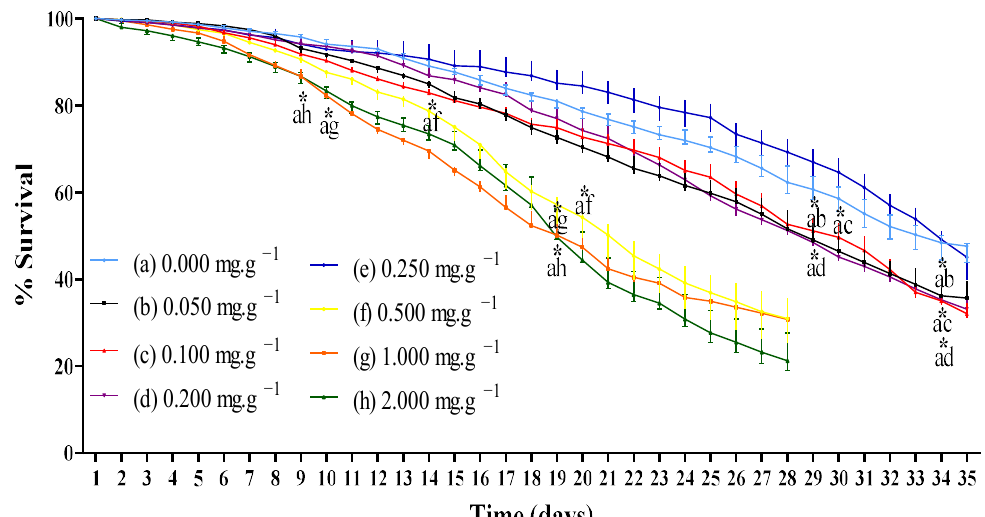
Figure 2. Survival curve of Drosophila melanogaster flies exposed to TFSR in different concentrations. The values are expressed as means ± S.E.M ( n = 3) as calculated by one-way ANOVA followed by Tukey’s multiple comparisons test, with a single pooled variance ( p < 0.05; 95% confidence interval). Letters a, b, c, d, e, f, g, and h represent concentrations of TFSR and (*) asterisks indicate significant differences between concentrations in the same timepoint (day).